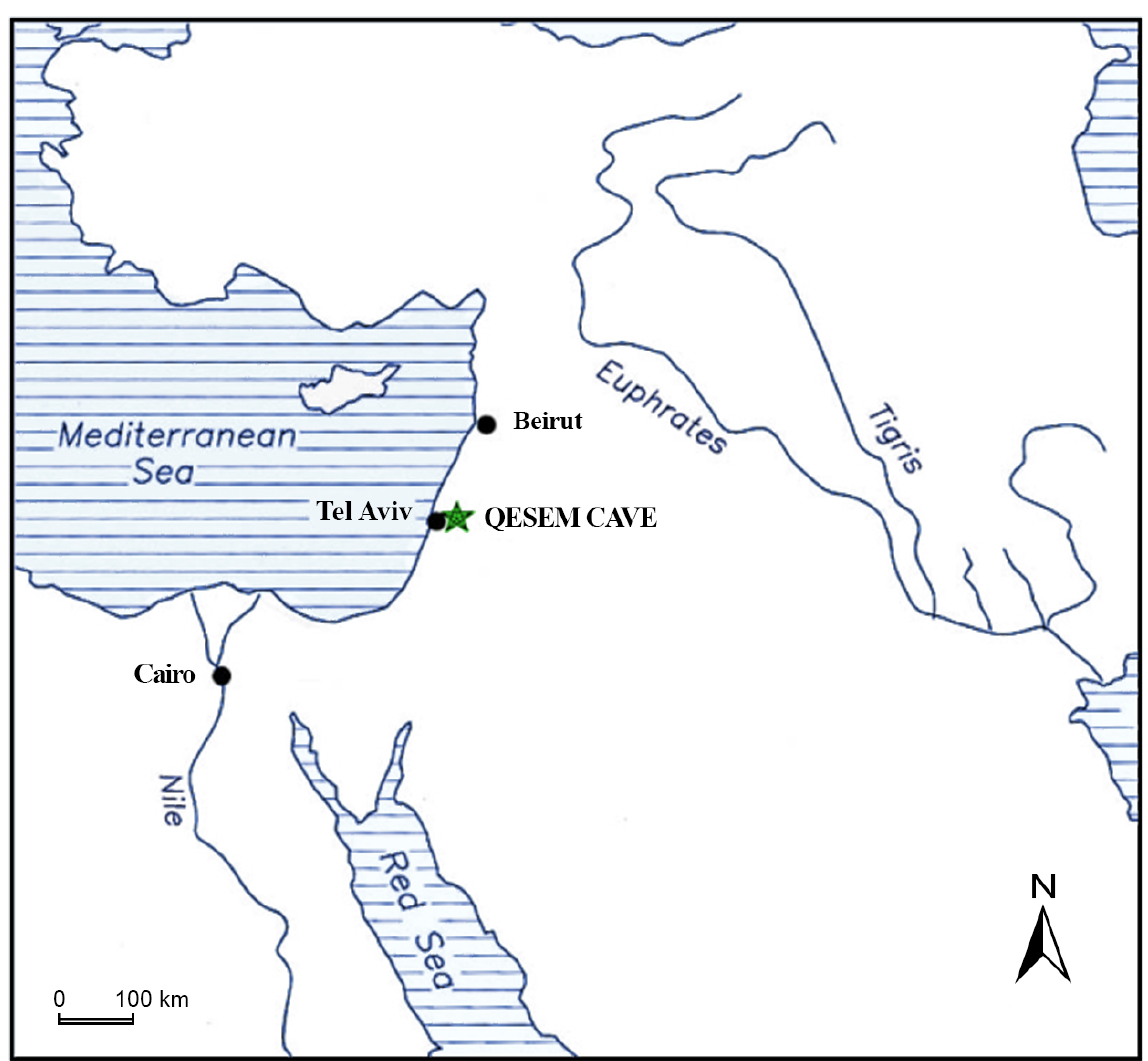
Figure 1. Location map of Qesem